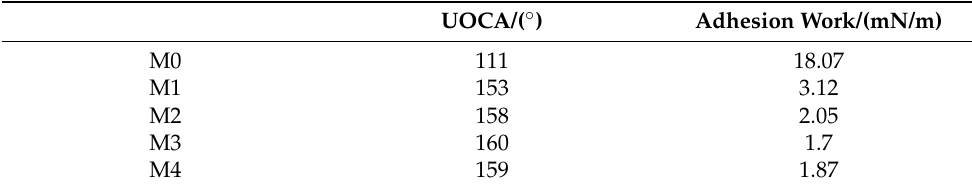
Table 1. The adhesion work of film M0, M1, M2, M3, M4.